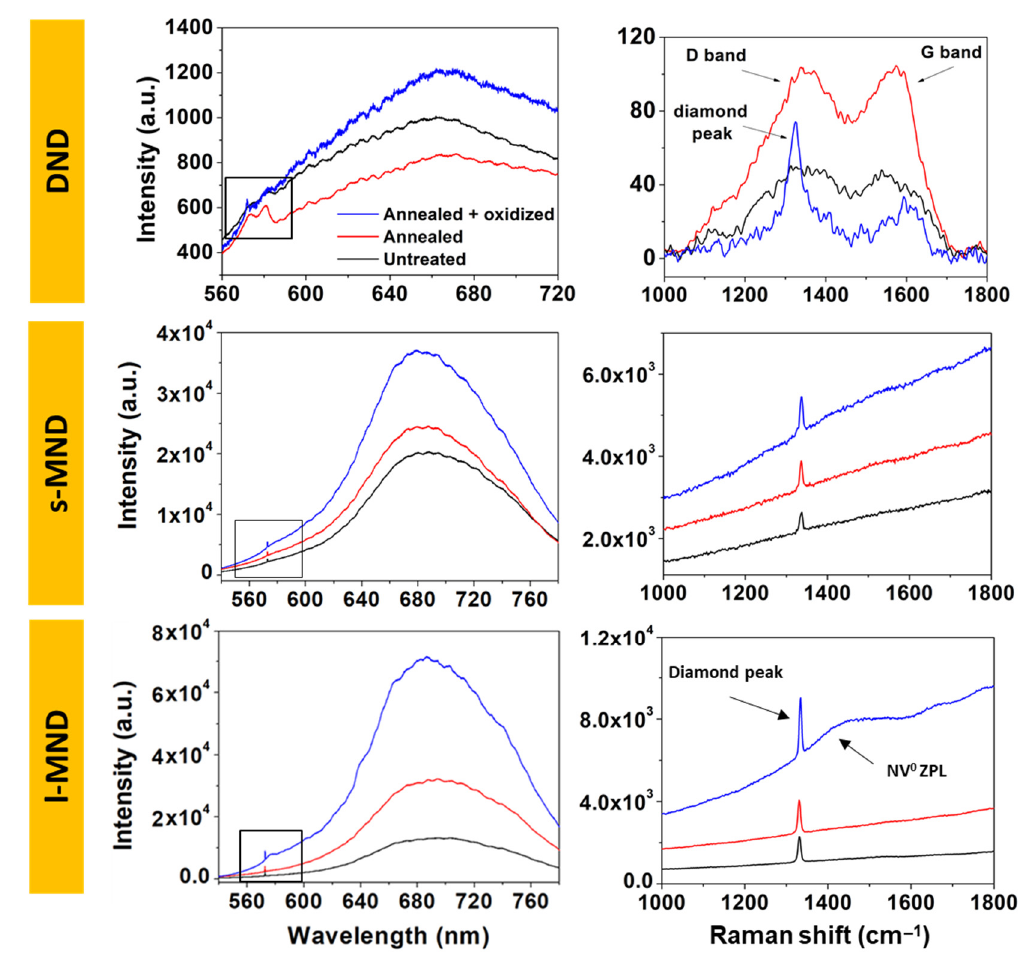
Figure 5. Photoluminescence spectra ( left ) and zoom of the main Raman features ( right ) of untreated, annealed, and annealed + oxidized DNDs, s-MNDs, and l-MNDs. A baseline was subtracted from the Raman spectra of DNDs to allow for better identification of D- and G- band signals.